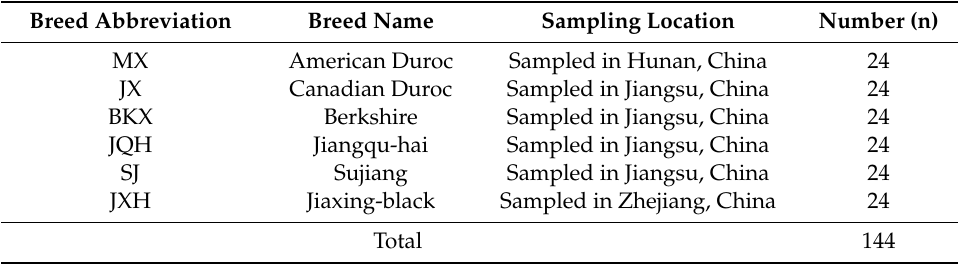
Table 1. Number of individual animals from six breeds used in this study. Breed